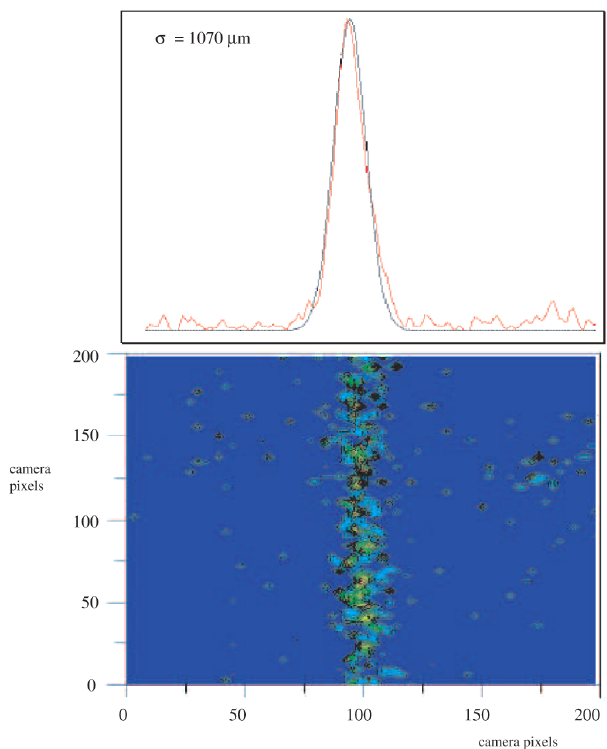
FIG. 11. (Color) Horizontal profile of a beam of fully stripped lead ions. The intensity is (cid:4) 10 9 ions, Z (cid:6) 82 and nitrogen pressure (cid:6) 6 (cid:5) 10 (cid:2) 7 Torr